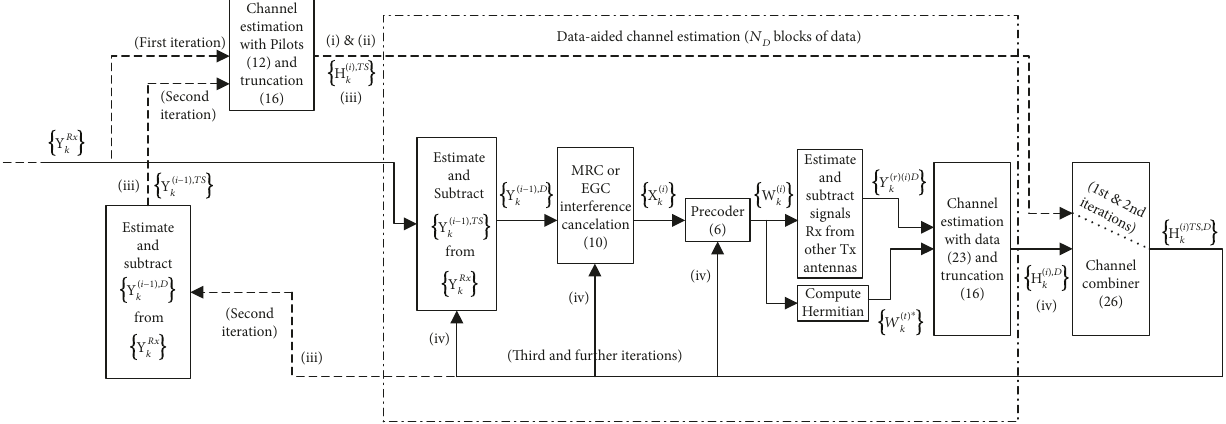
Figure 3: Block diagram of m-MIMO receiver with interference canceller and channel estimation, using